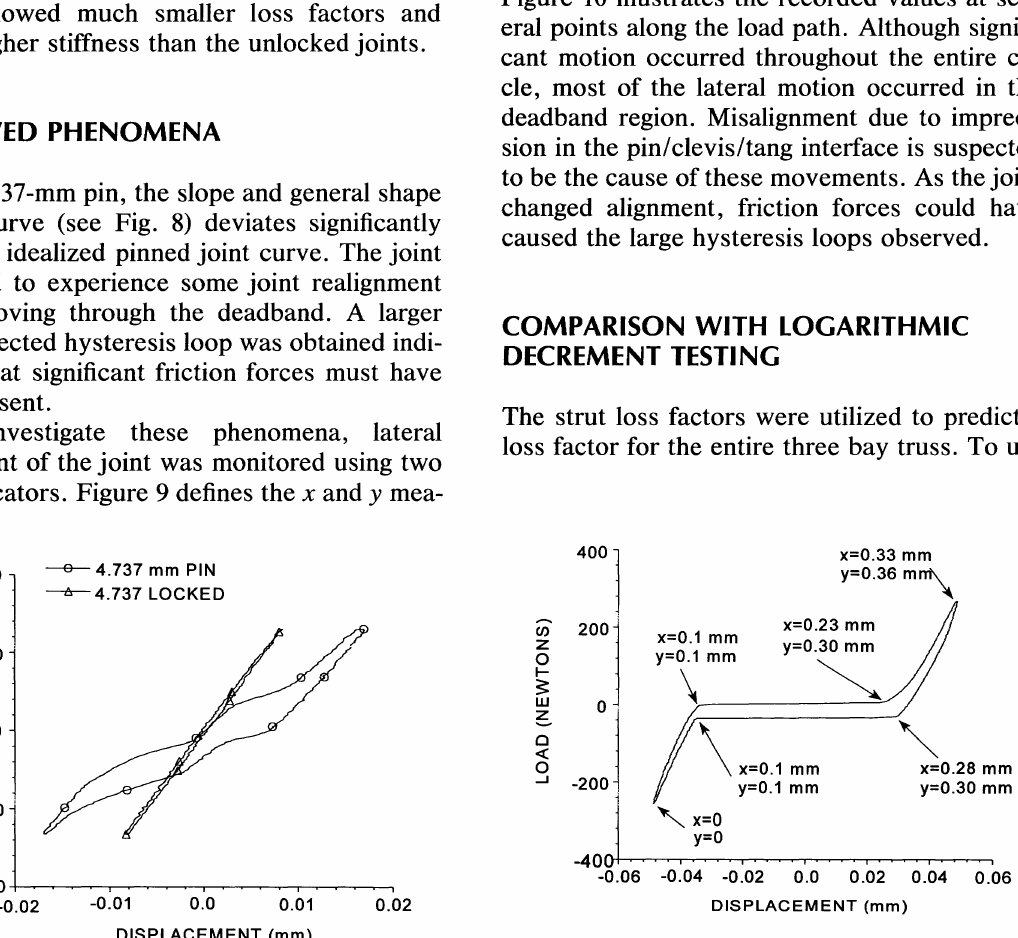
FIGURE 10 Illustration of the joint movement in off axis